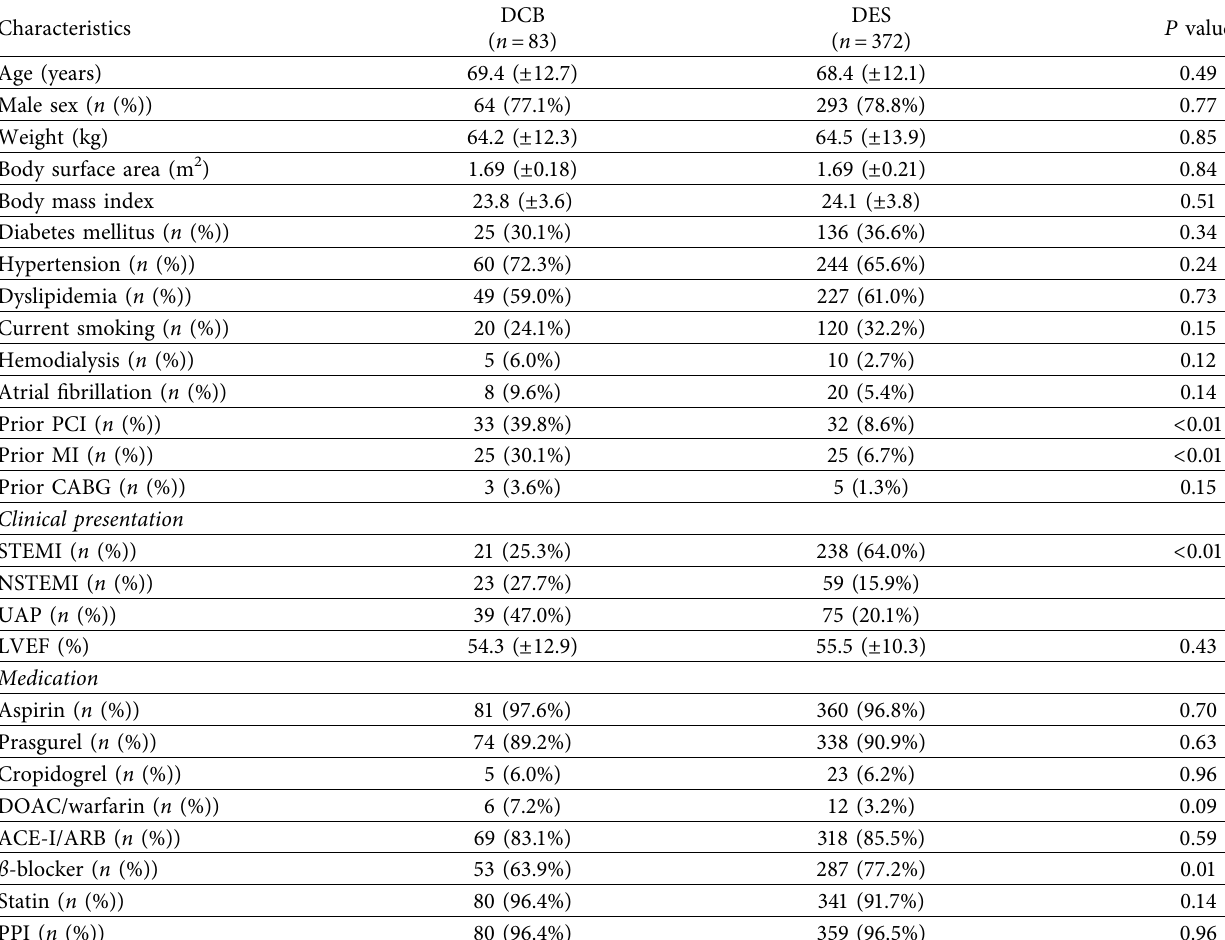
Table 1: Baseline